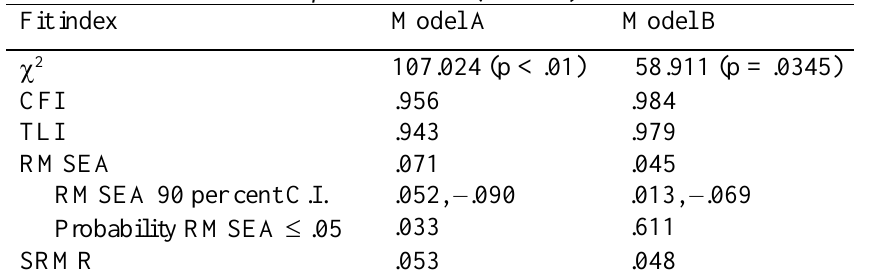
Fit Indices for the two Proposed Models (A and